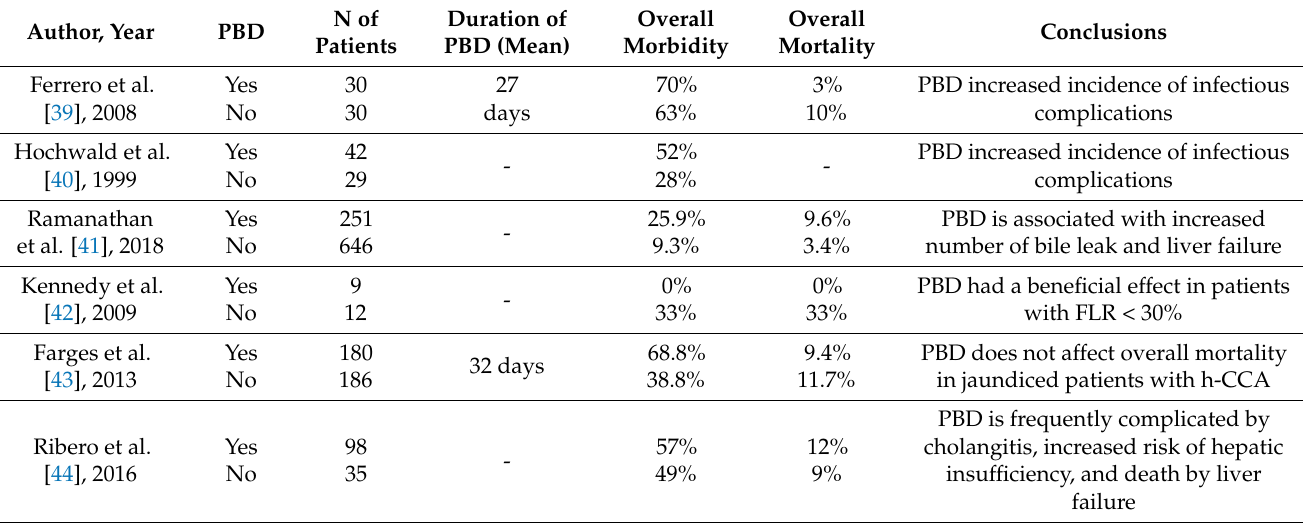
Table 1. Management of PBD in perihilar cholangiocarcinoma